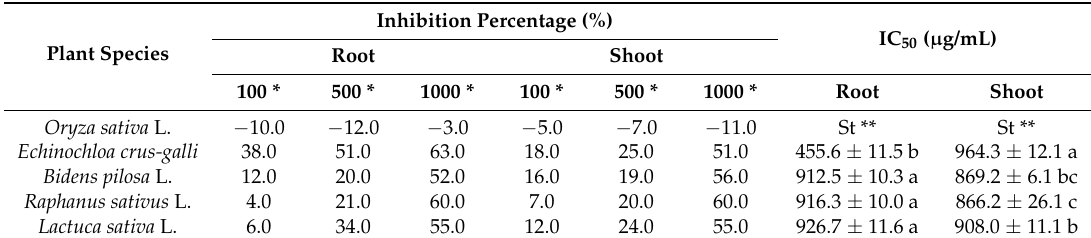
Inhibition Percentage (%) Root Shoot